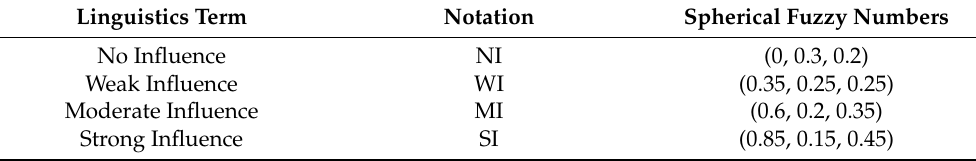
Table 2. Linguistics term and respective SFNs for the SF DEMATEL method. Linguistics